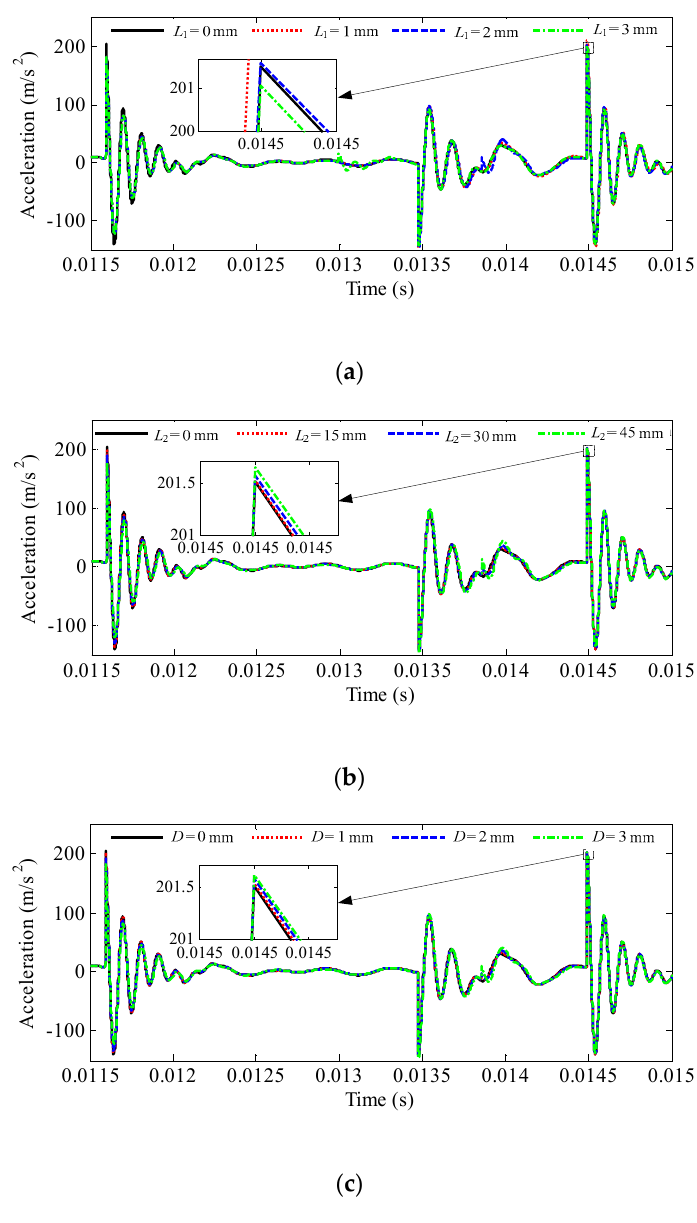
Figure 9. Effects of crack parameters on the acceleration responses: ( a ) length, ( b ) width, ( c ) depth.